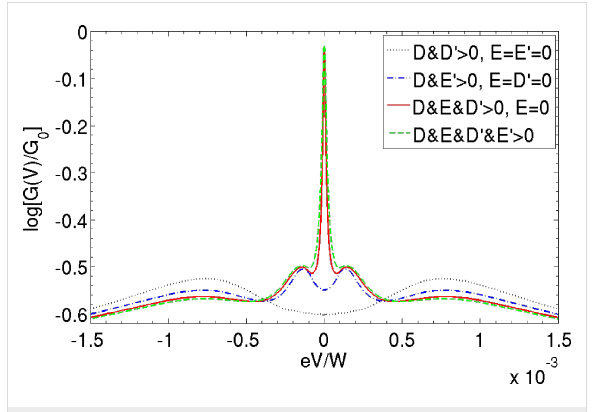
Figure 3: Effect of the spin–vibration coupling on the QST-Kondo peak: SMM differential conductance shown for various combinations of zero and nonzero values of the parameters. Nonzero values used: D ′ = 0.04 D , E ′ = 0.16 D and E = 0.02 D . Remaining parameters as in Figure 2.